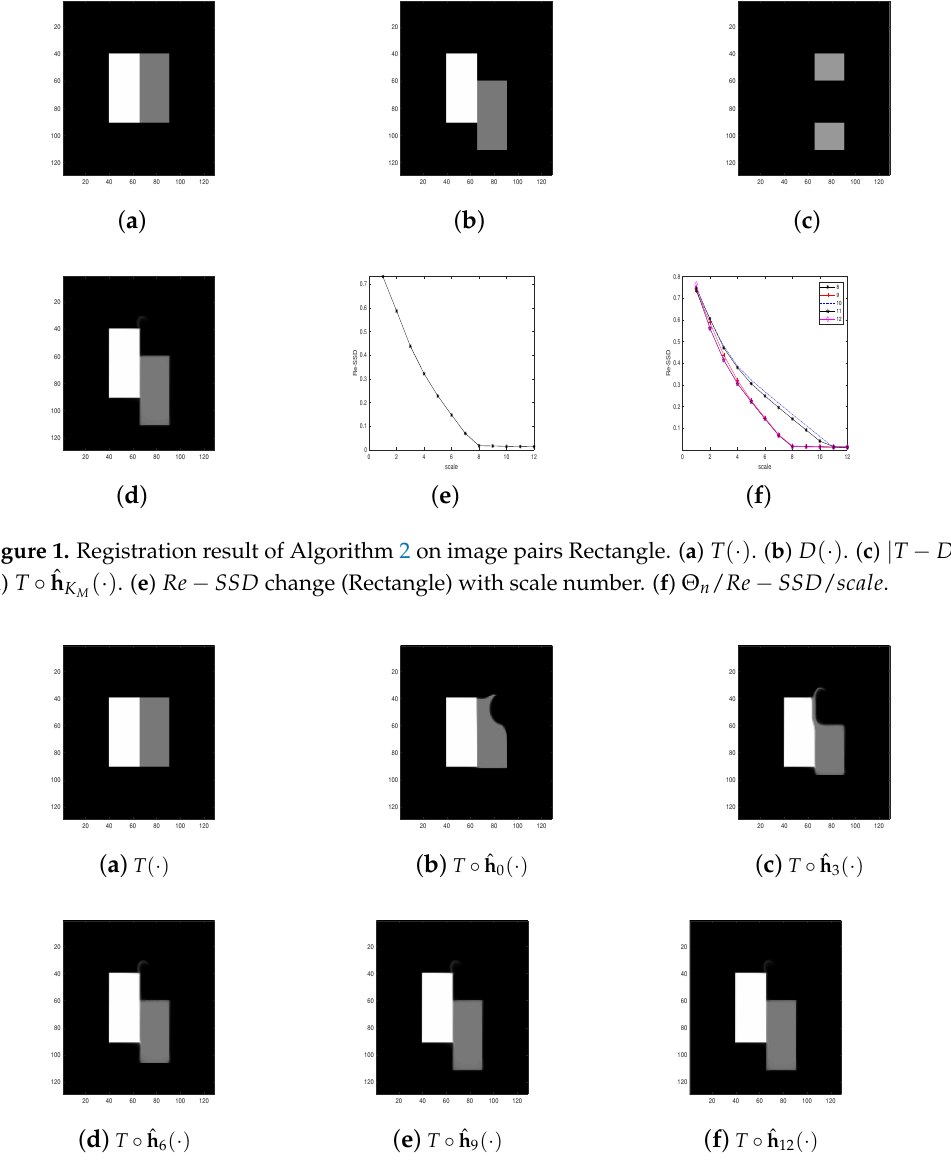
Figure 2. Registration result for different scales on image pairs Rectangle. ( a ) T ( · ) . ( b ) Re − SSD = 73.29%. ( c ) Re − SSD = 43.84%. ( d ) Re − SSD = 14.75%. ( e ) Re − SSD = 1.65%. ( f ) Re − SSD =